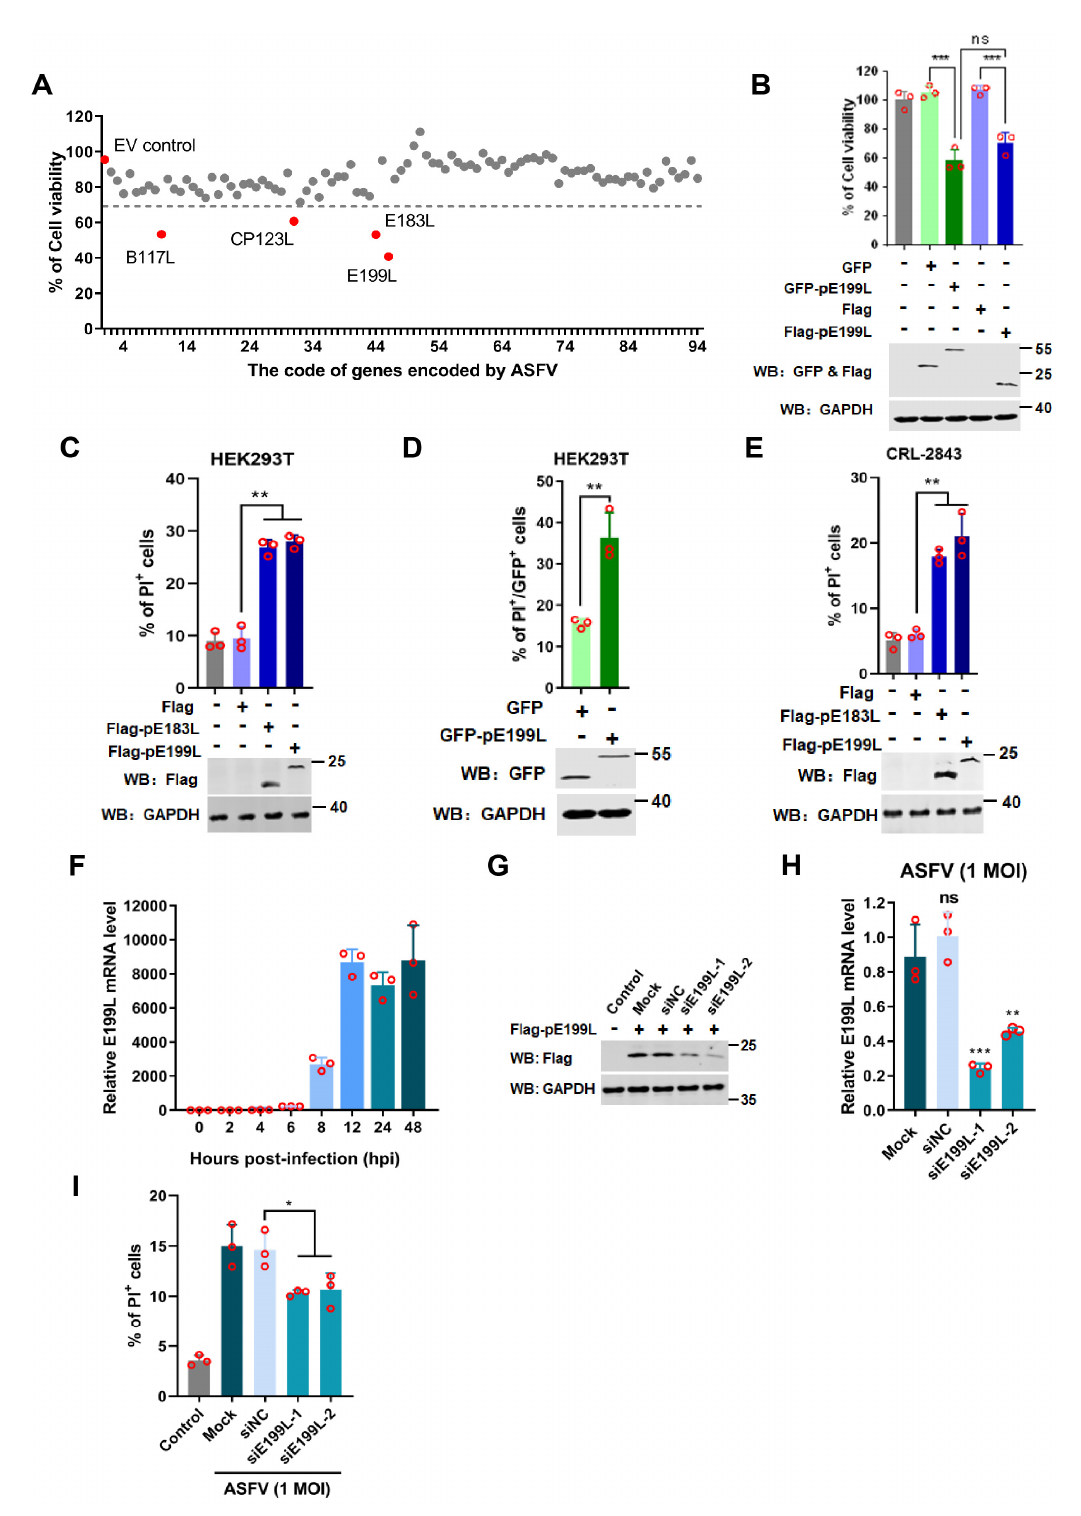
Figure 2. ASFV pE199L induces cell death. ( A ) Screening of the ASFV genes involved in cell death in vitro. HEK293T cells were transfected with a plasmid expressing 1 of the 94 ASFV-encoded proteins for 36 h and then examined for cell viability. The genes corresponding to relative cell viability (normalized to the empty vector control) below the dotted line were